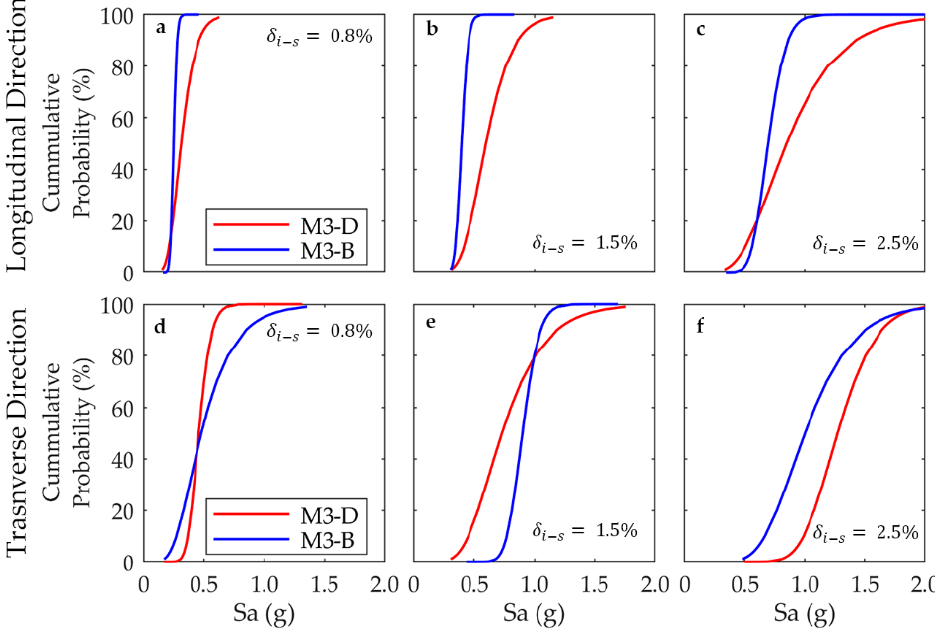
Figure 13. Fragility curves for different levels of inter-story drift ( 𝛿 (cid:3036)(cid:2879)(cid:3046) ) for the ductile (M3-D) and brittle (M3-B) cases. Longitudinal direction: ( a ) 𝛿 (cid:3036)(cid:2879)(cid:3046) = 0.8%, ( b ) 𝛿 (cid:3036)(cid:2879)(cid:3046) = 1.5%, and ( c ) 𝛿 (cid:3036)(cid:2879)(cid:3046) = 2.5%. brittle (M3-B) cases. Longitudinal direction: ( a ) δ i − s = 0.8%, ( b ) δ i − s = 1.5%, and ( c ) δ i − s = Transverse direction: ( d ) 𝛿 (cid:3036)(cid:2879)(cid:3046) = 0.8%, ( e ) 𝛿 (cid:3036)(cid:2879)(cid:3046) = 1.5%, and ( f ) 𝛿 (cid:3036)(cid:2879)(cid:3046) = 2.5%.